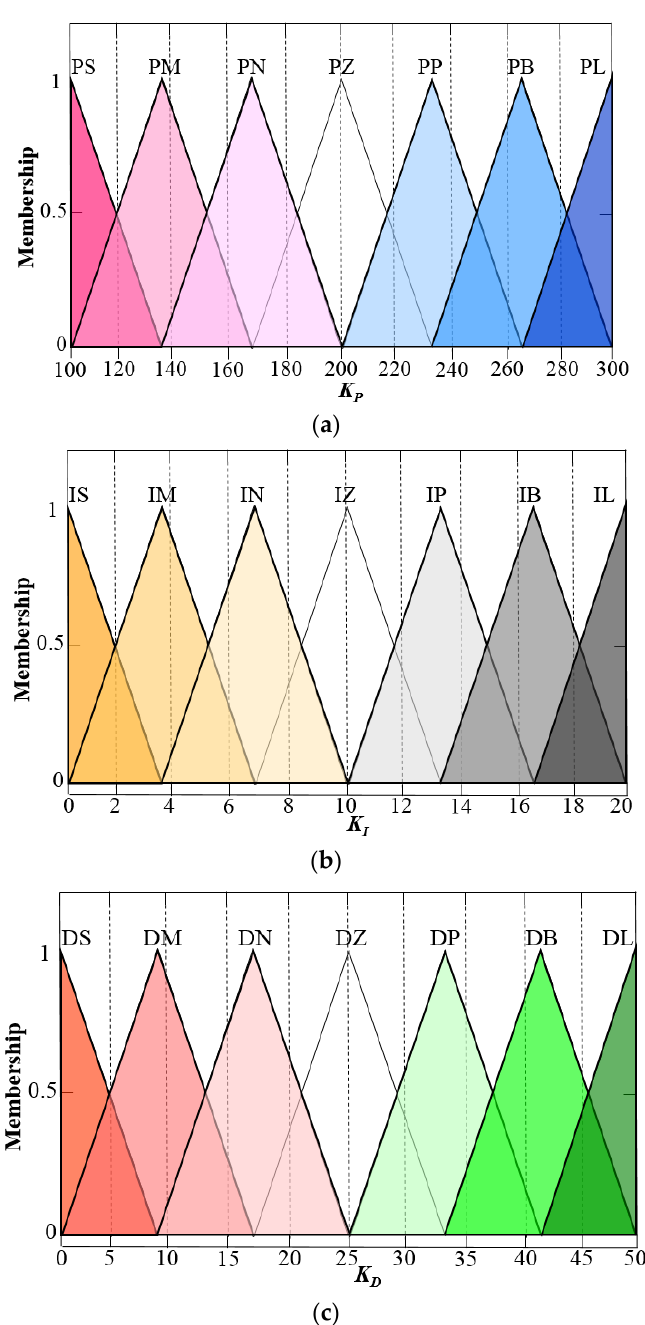
Figure 2. Fuzzy value distribution of K p ( a ), K I ( b ), K D ( c ). ⚫ Eccentric fuzzy rules design